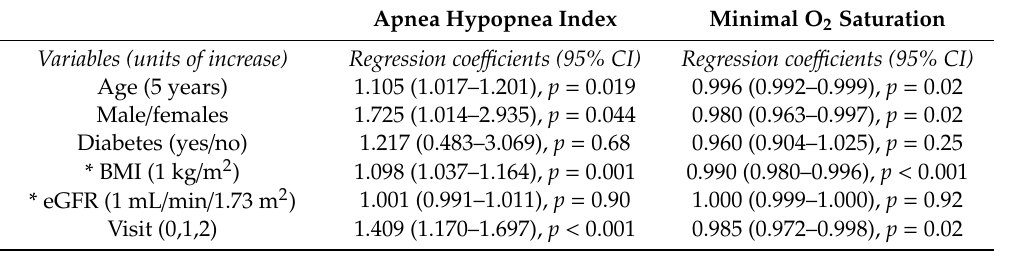
Table 2. Adjusted multiple generalized estimating equations (GEE) of Apnea Hypopnea Index (AHI) and minimal nocturnal O 2 saturation over time. The model includes all univariate correlates of AHI at baseline with p < 0.10 (age, gender, diabetes as well as the BMI and estimated glomerular filtration rate (eGFR). BMI and eGFR are tested as repeated measures). Data are regression coe ffi cients, 95% CI and p